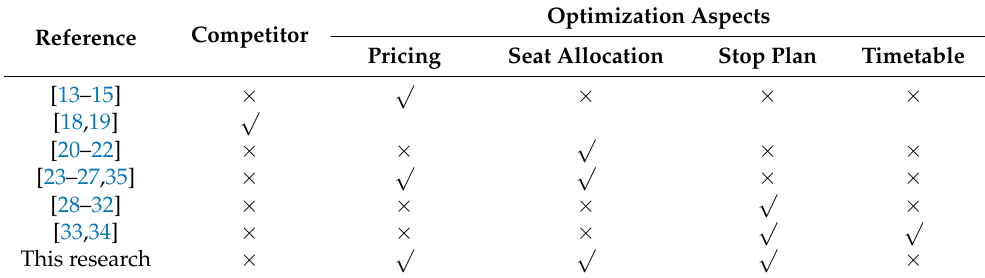
Table 1. Summary of literature